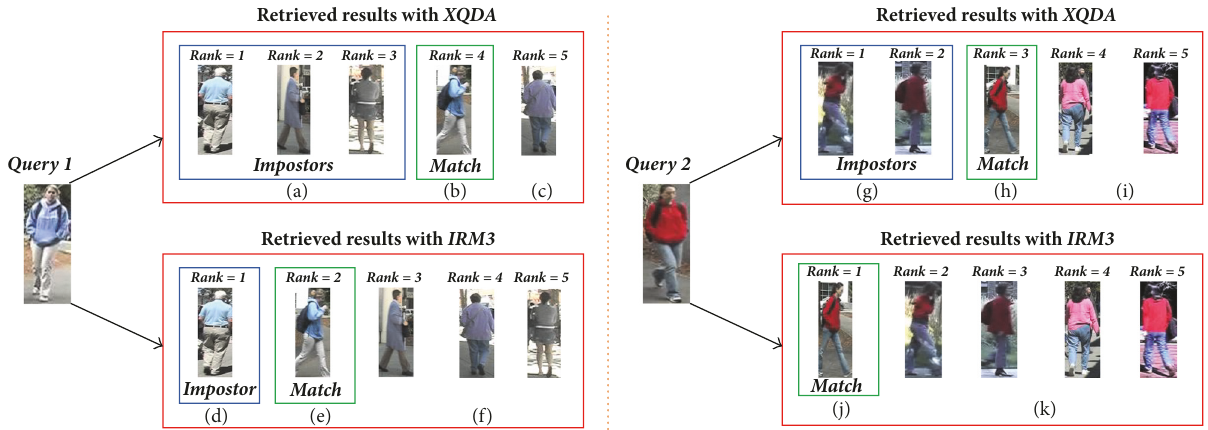
Figure 3: Two queries are shown, Query 1 and Query 2 , and their retrieval results using XQDA [11] and our IRM3. Correct match is shown in green rectangle, while blue rectangle shows impostors.